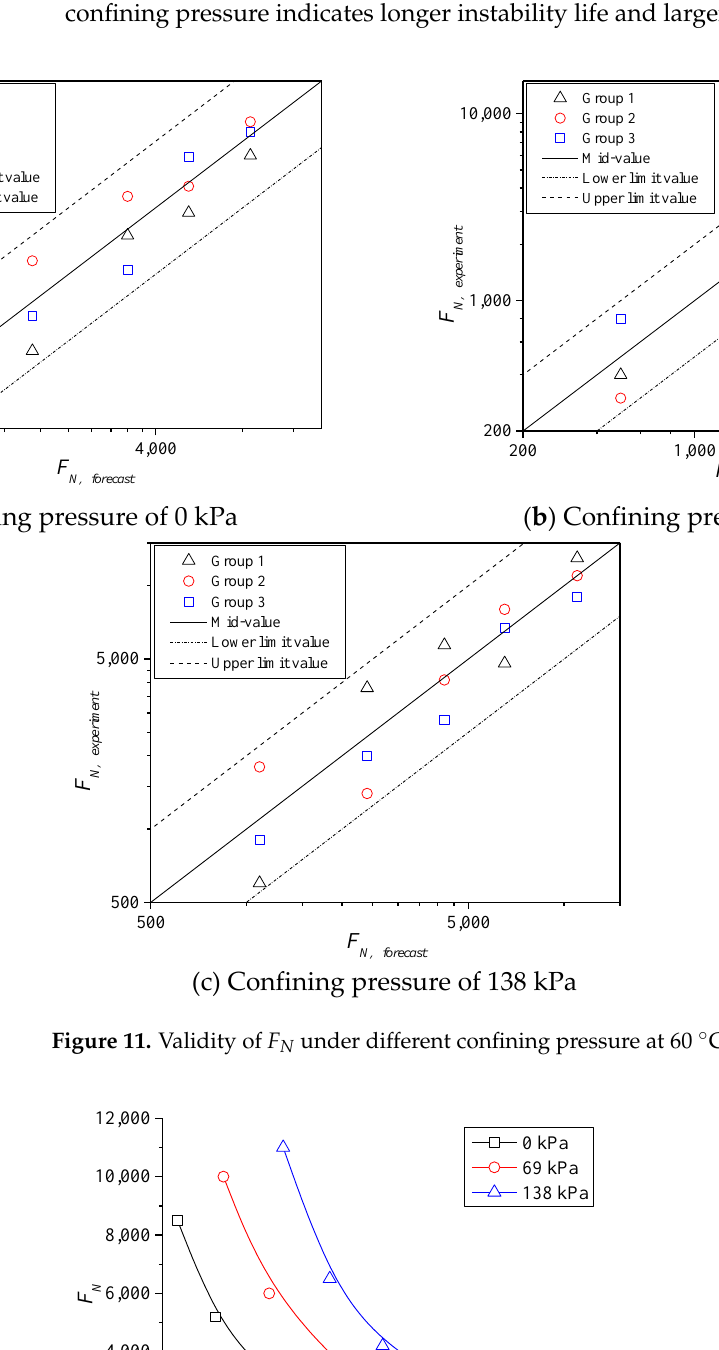
 n /  0 Figure 13. Curve chart of F N with shear stress ratio. The following exponential function model was selected to fit the results in Figure 13, as follows: b 0 a( ) n N F  